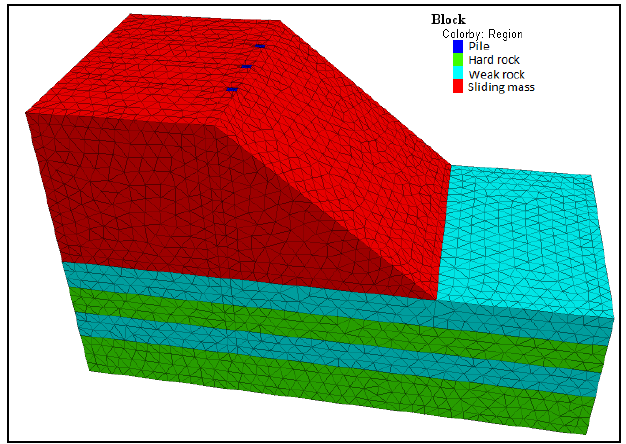
Figure 14. Numerical model diagram of the corresponding model test.